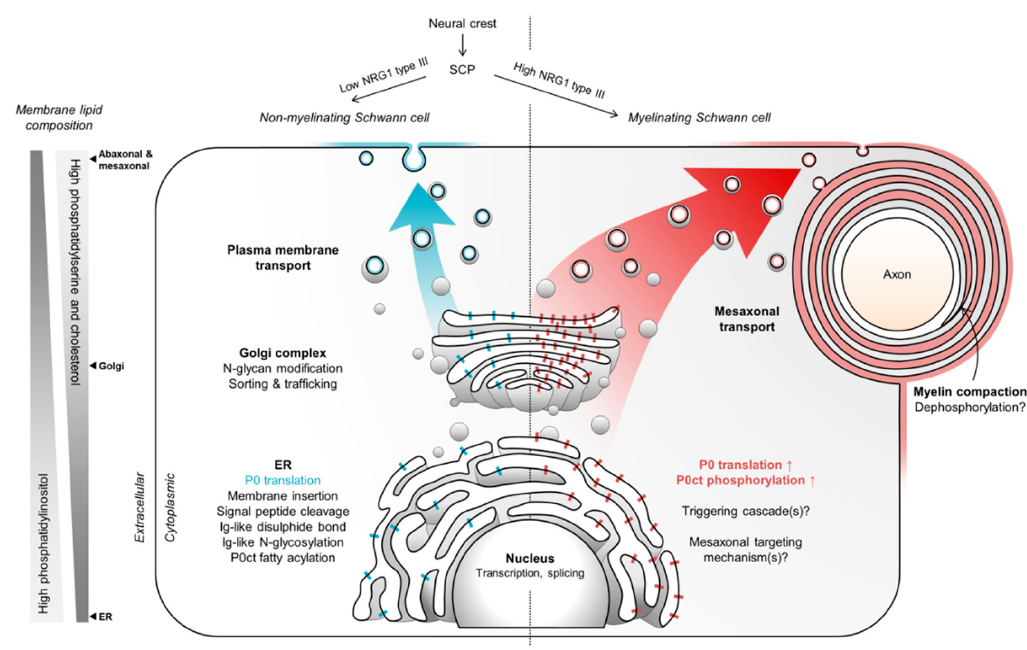
Figure 4. The expression and trafficking of P0 in Schwann cells. SCPs emerge from the neural crest and form non-myelinating Schwann cells under low NRG1 conditions. These cells express P0 at a basal level and target it to the plasma membrane. This process normally does not form myelin-like structures, but in myelinating Schwann cells that proliferate from SCPs at high NRG1 levels, P0 targeting shifts to the mesaxon via unknown mechanisms. Potential myelination-involved factors include intermolecular interactions between P0 molecules, the phosphorylation of P0ct, and/or altered membrane lipid compositions. The changing lipid environment between different membranes affects the partitioning and trafficking of P0 [118,119,150].